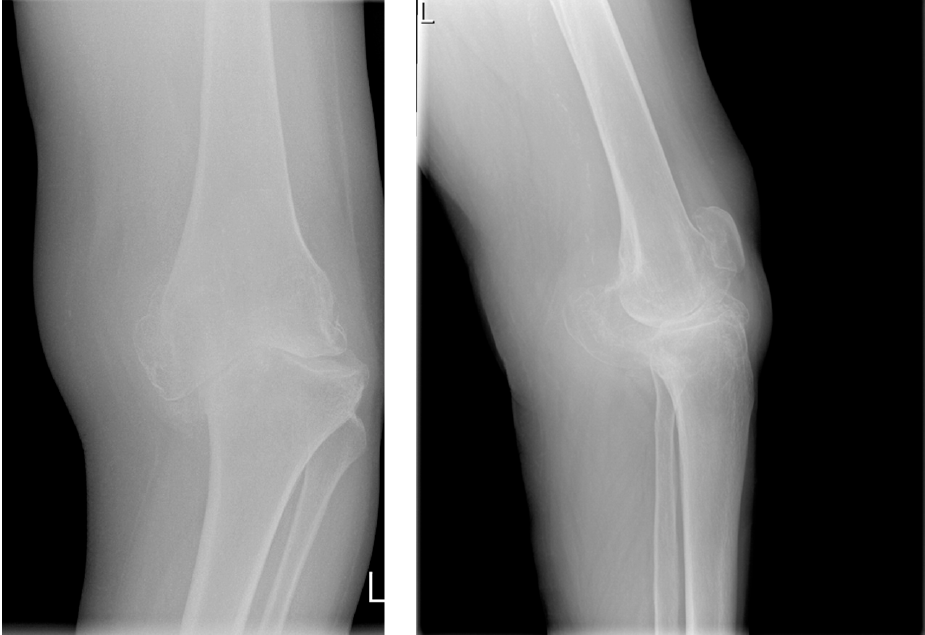
Figure 2. Osteoarthritis of the left knee joint, stage 4 on the Kellgren–Lawrence scale. Advanced destruction of the medial condyle of the femur (upper part) and tibia (lower part). Roentgenograms in AP ( left ) and lateral positions ( right ). Source: proprietary material.